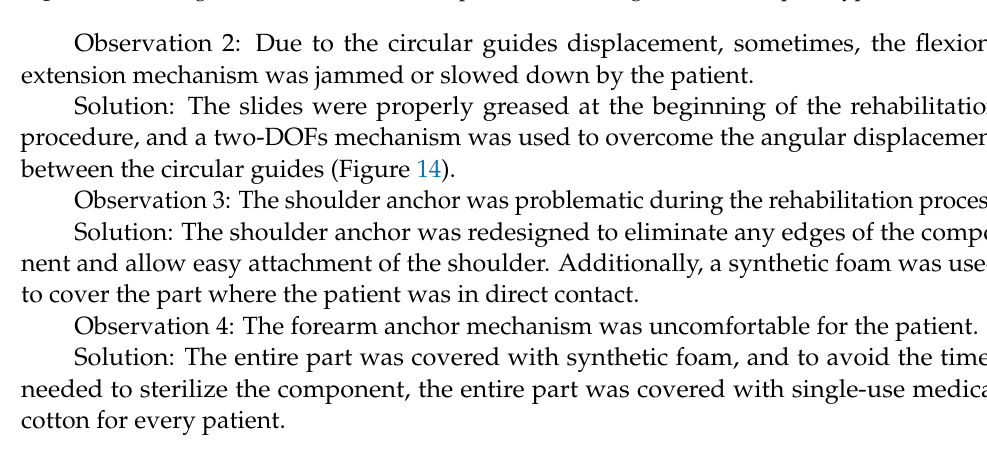
Figure 14. Two-Degrees of Freedom (DOF) mechanism between the circular guides. Observation 3: The shoulder anchor was problematic during the rehabilitation pro- cess. Solution: The shoulder anchor was redesigned to eliminate any edges of the compo- nent and allow easy attachment of the shoulder. Additionally, a synthetic foam was used to cover the part where the patient was in direct contact. Observation 4: The forearm anchor mechanism was uncomfortable for the patient. Solution: The entire part was covered with synthetic foam, and to avoid the times needed to sterilize the component, the entire part was covered with single-use medical cotton for every patient. Observation 5: During the use of the system, the motor of the adduction–abduction mechanism heated up.